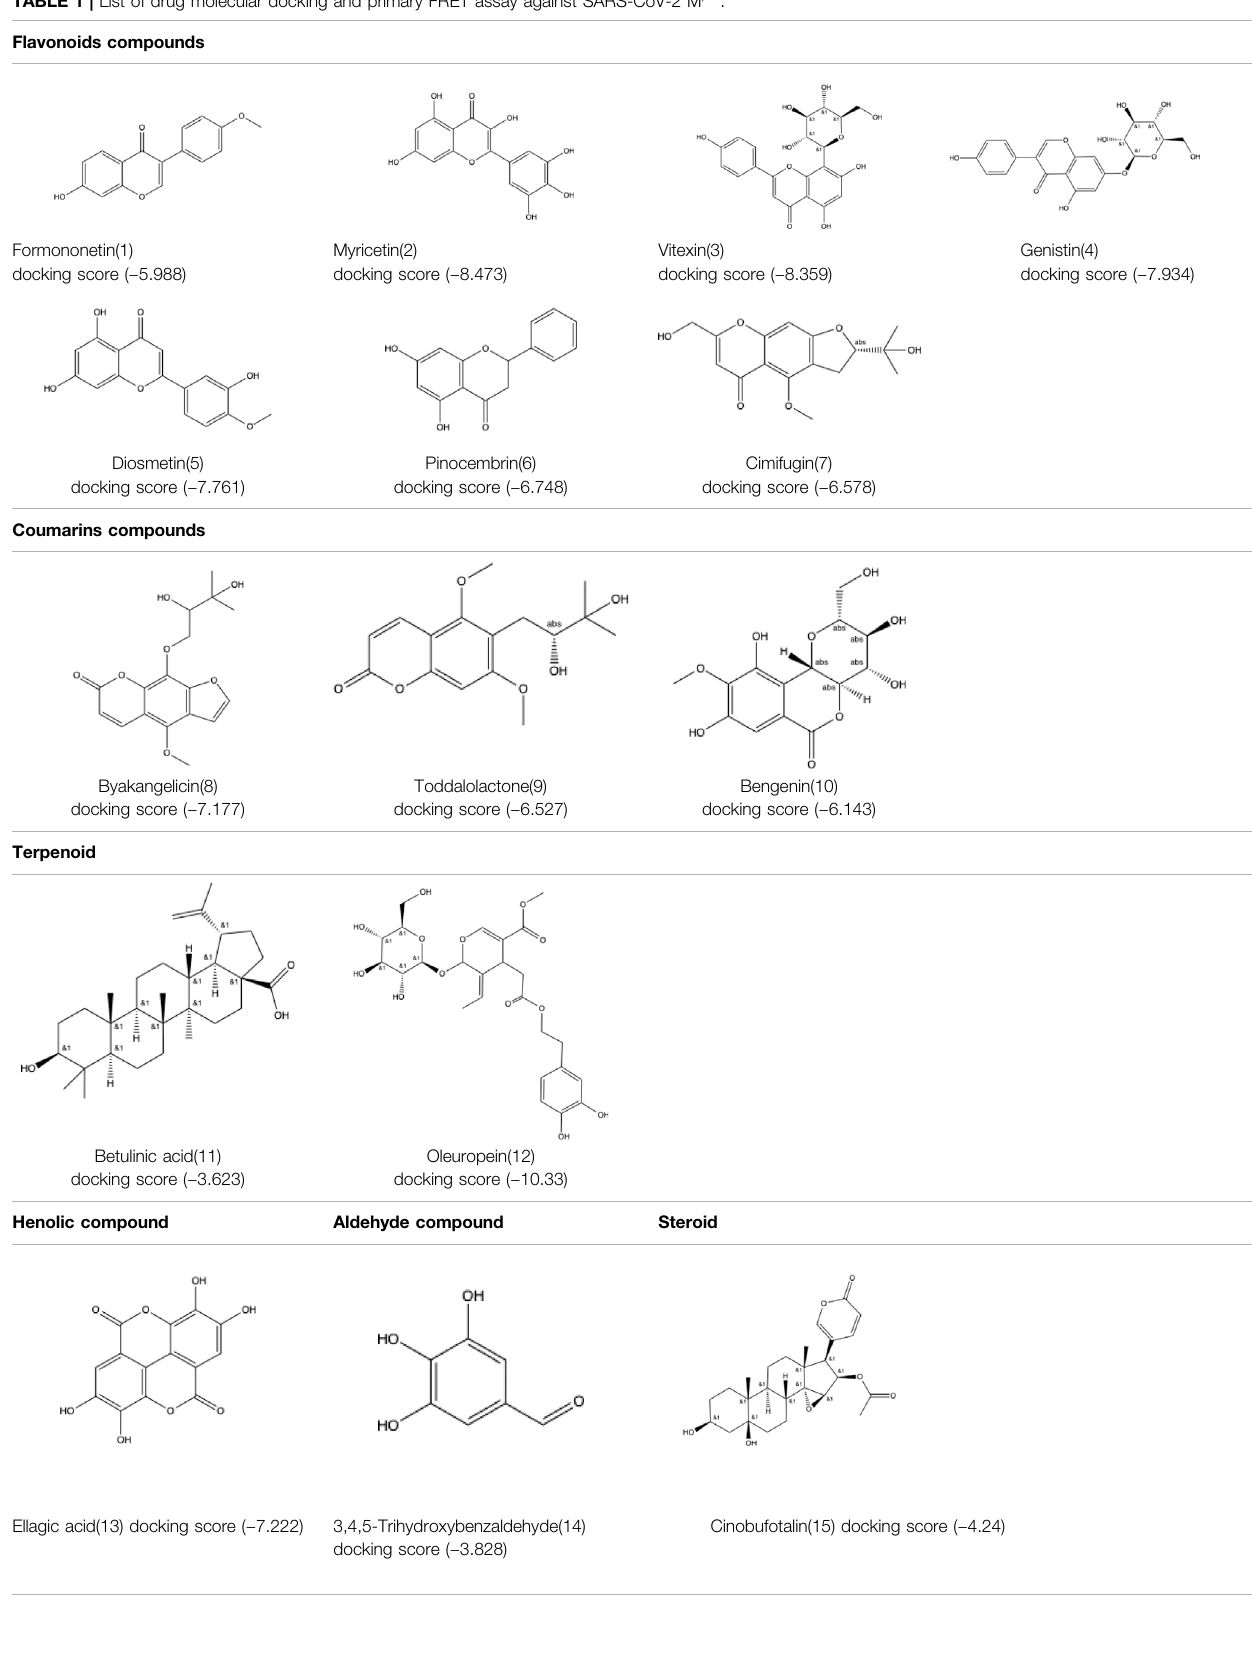
TABLE 1 | List of drug molecular docking and primary FRET assay against SARS-CoV-2 M pro . Flavonoids